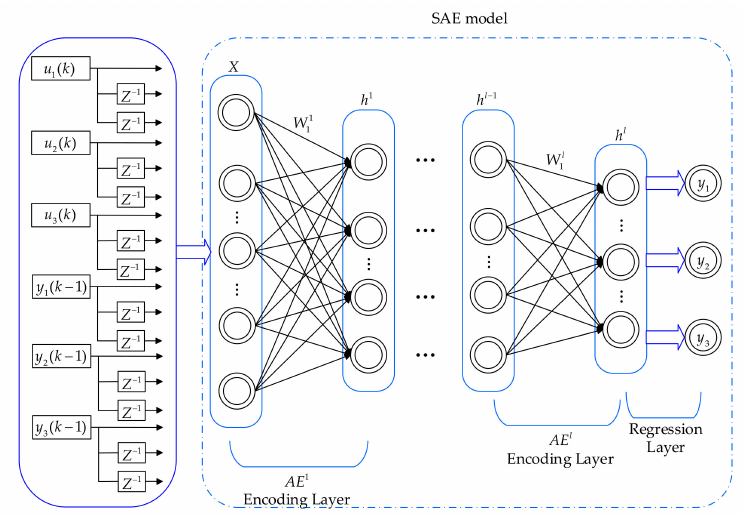
Figure 5. Structure of the SAE used for USC modeling.